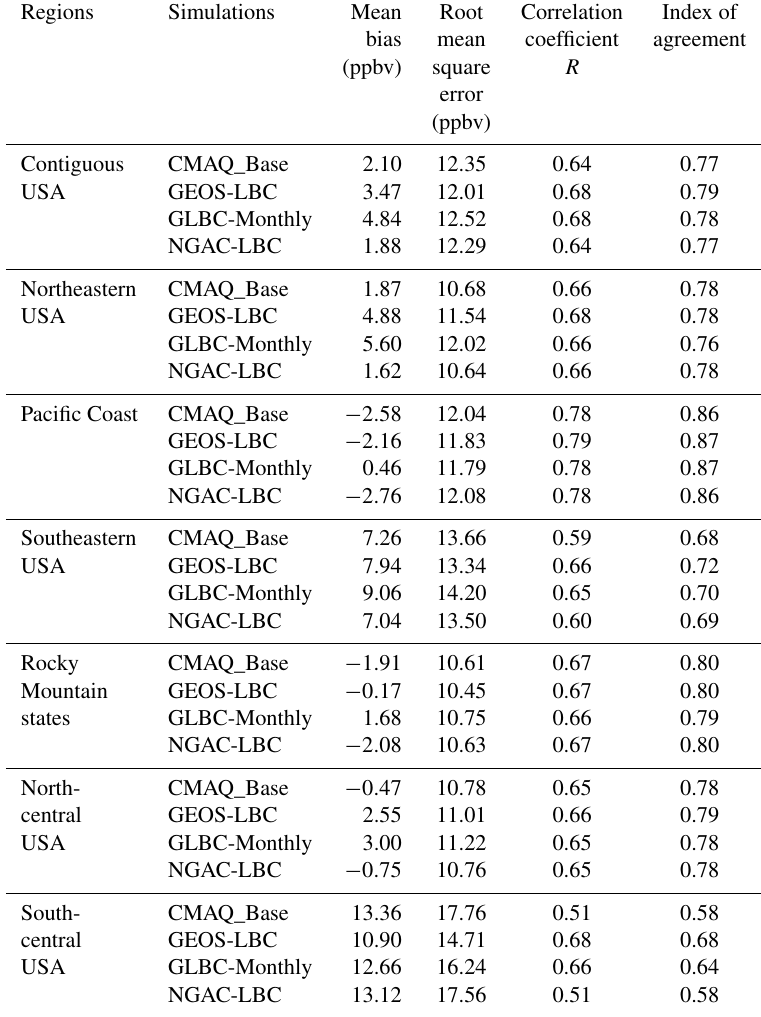
Table 5. Same as Table 4 but for